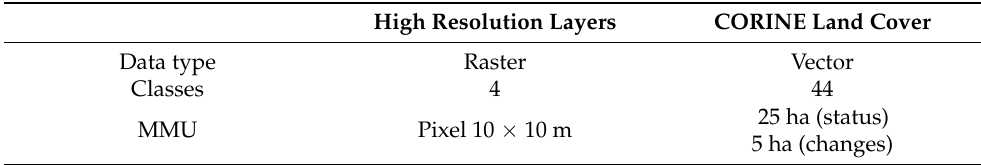
Table 3. Copernicus Land Monitoring Service—Pan-European component